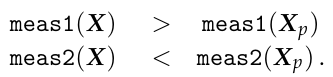
Algorithm 2 Unsupervised SOM